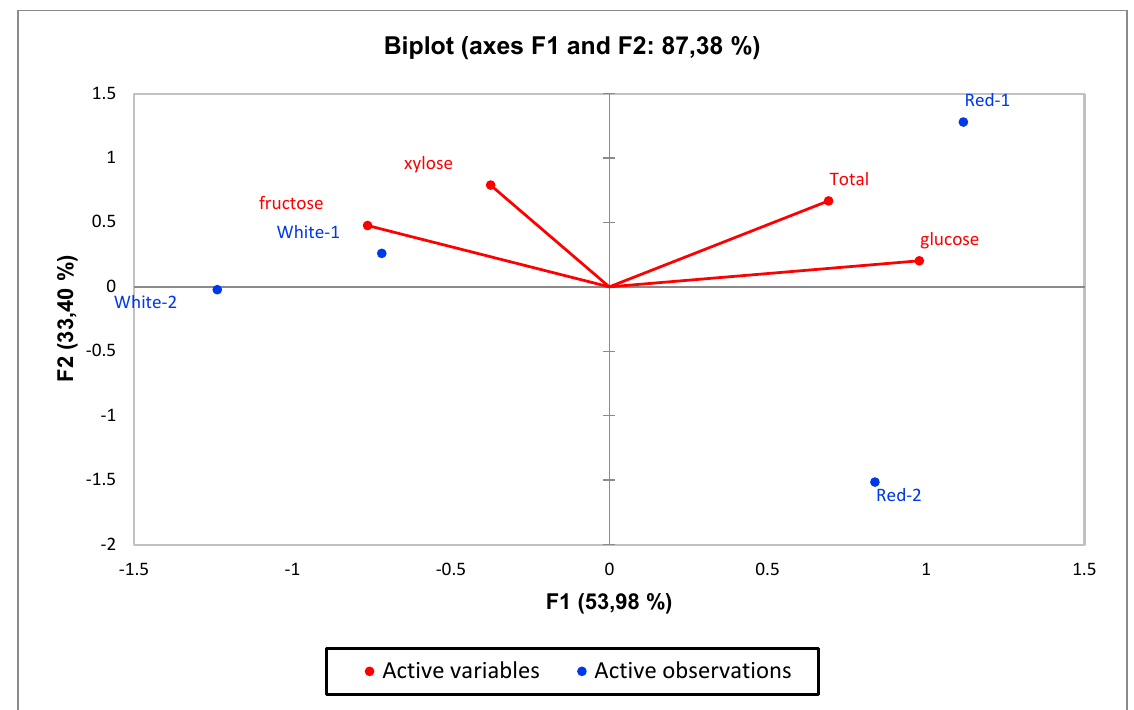
Figure 2. Biplot graph (scores and loading plots) obtained from Principal Component Analysis for sugars in red-white pitaya.